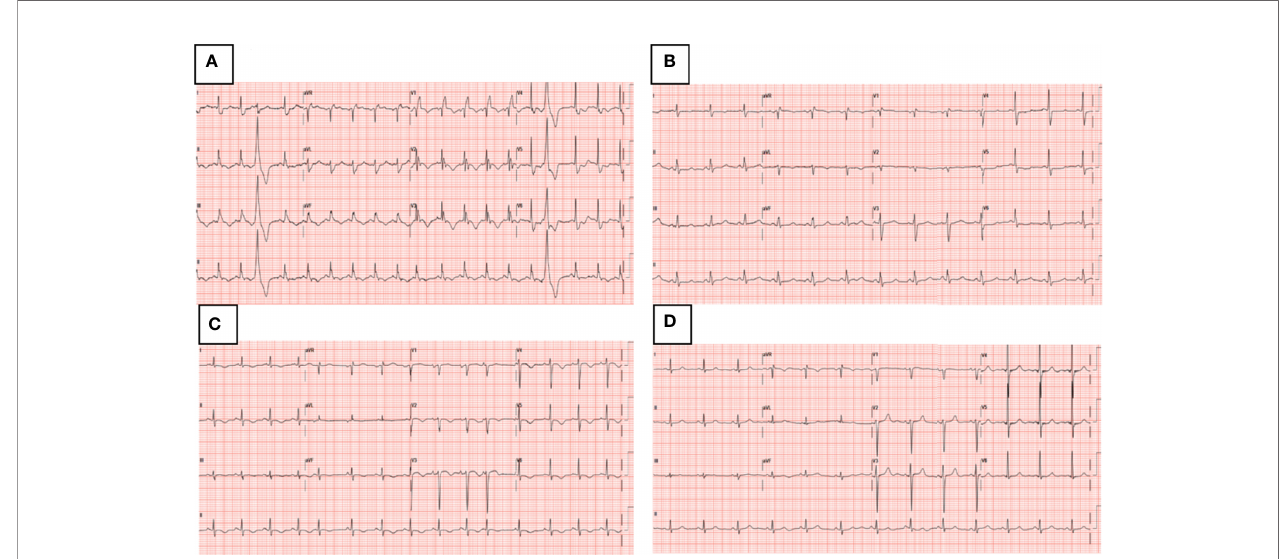
FIGURE 5 | Dynamic ECG changes (A) ECG on admission to Day Hospital, complete right bundle branch block that has previously been absent and QT interval prolongation up to 510 ms (<460 ms), (B) ECG on admission to Cardiac Intensive Care Unit, right bundle branch hemiblock, (C) ECG after intravenous catecholamines, T-wave inversion, (D) ECG at 2 months follow-up,